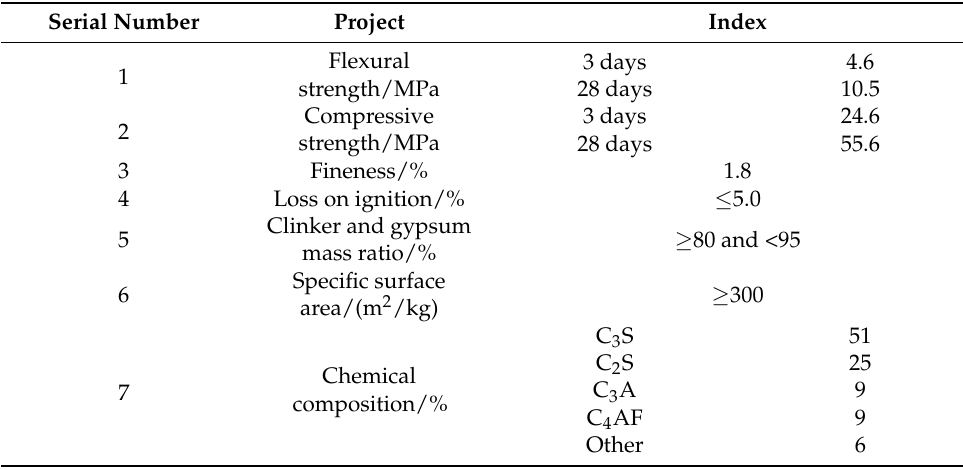
Table 1. 42.5 Physical and mechanical properties of ordinary silicate cement.